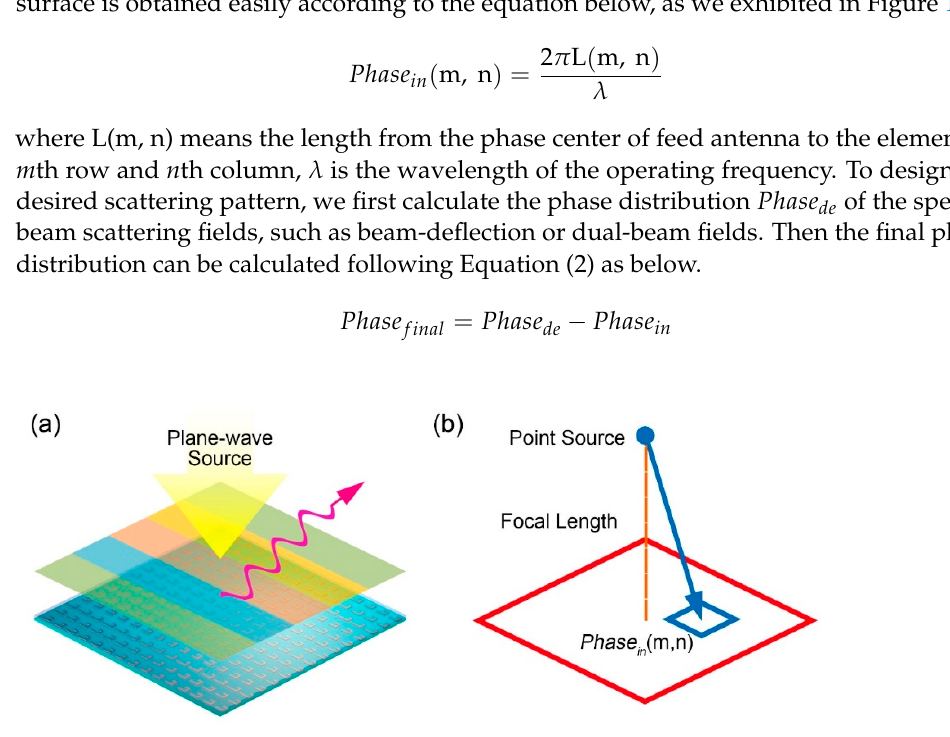
Figure 1. The schematic of the presented reconfigurable metasurface antenna. ( a ) The anomalous refraction under plane-wave incidence. ( b ) The incident phase calculation of the point source feed.